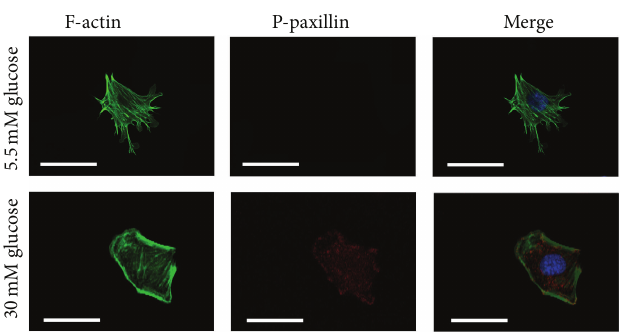
Figure 9: F-actin and paxillin expression by immunofluorescence. Under low glucose conditions (column 1), paxillin phosphorylation was undetectable and F-actin was distributed along the cell axis. After 48 hours of 30 mM glucose stimulation (column 2), the activation of paxillin was markedly upregulated with F-actin expressed at the cortical regions of the podocytes. Magnification: